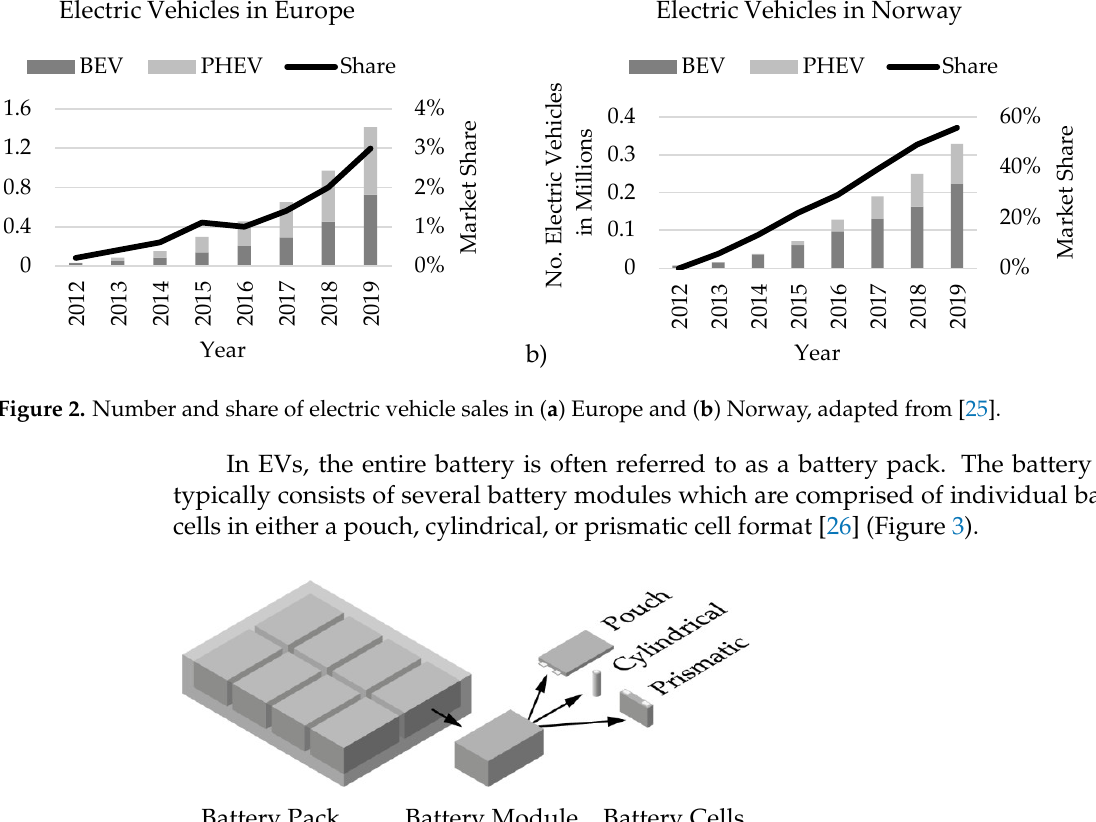
Figure 3. Battery assembly in an electric vehicle.